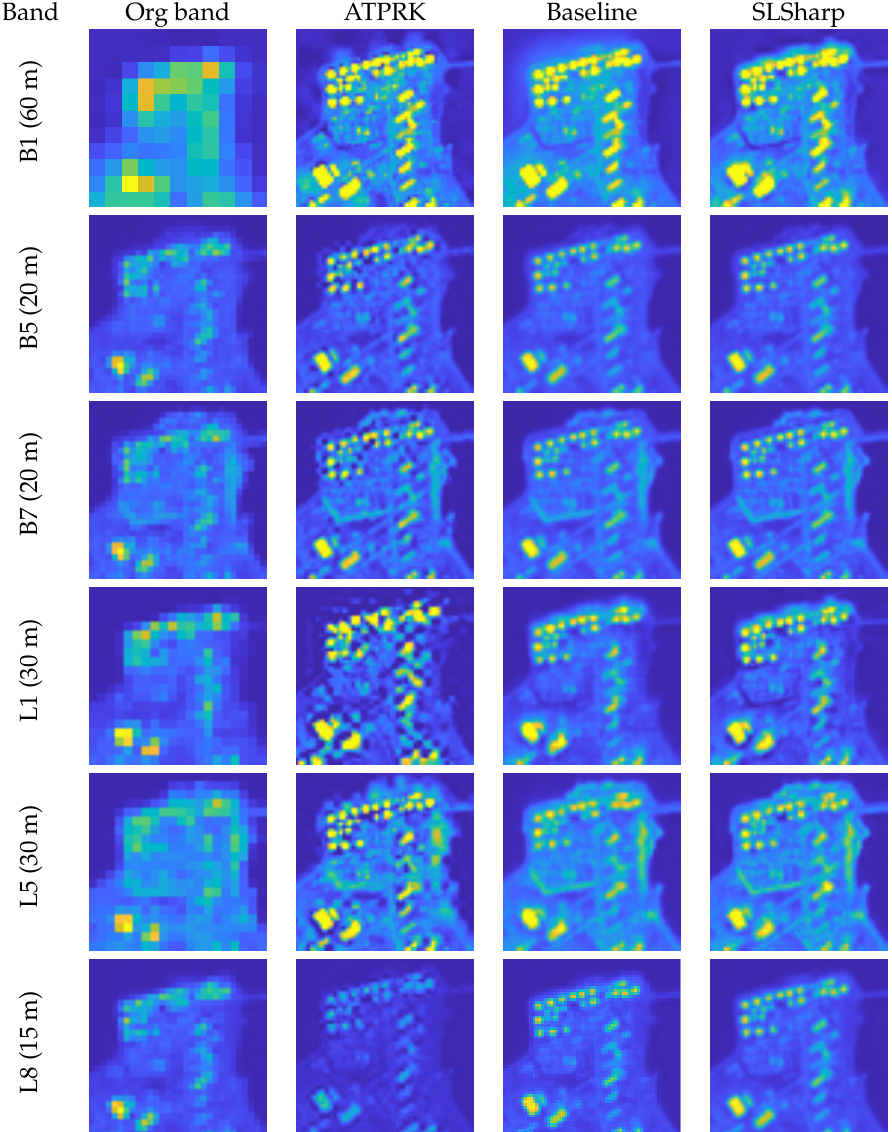
Figure 4. The results that were obtained by sharpening the Sentinel-2 bands 2, 5, and 7 and Landsat 8 bands 1, 5, and 8 of the IS image. The original bands are in the leftmost column, the results from the ATPRK method are in the middle-left column, the results from the modified SupReME (baseline) method are in the middle-right column, and the results from SLSharp are in the rightmost column. By examining the results within the ROI in Figures 4 and 5, it could be seen that SLSharp outperformed the ATPRK and baseline methods in all bands. The images that were ob- tained using SLSharp had more detail and the outlines of the buildings were crisper and had fewer